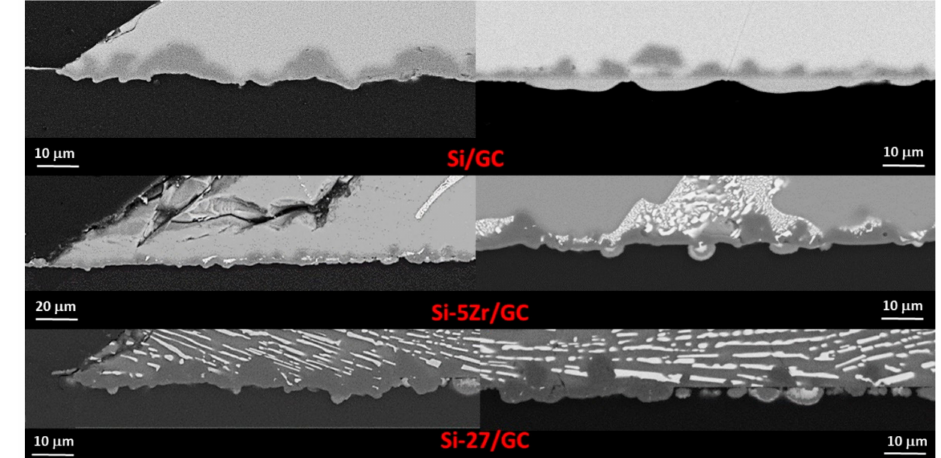
Figure 9. SEM-BSE images at di ff erent magnifications and proposed phase identification by EDS analyses that were performed at (left side) the triple lines and at (right side) the interfaces close to the middle of the Si / GC, Si-5Zr / GC and Si-27Zr / GC samples after the wetting tests that were performed at T = 1450 ◦ C for 15